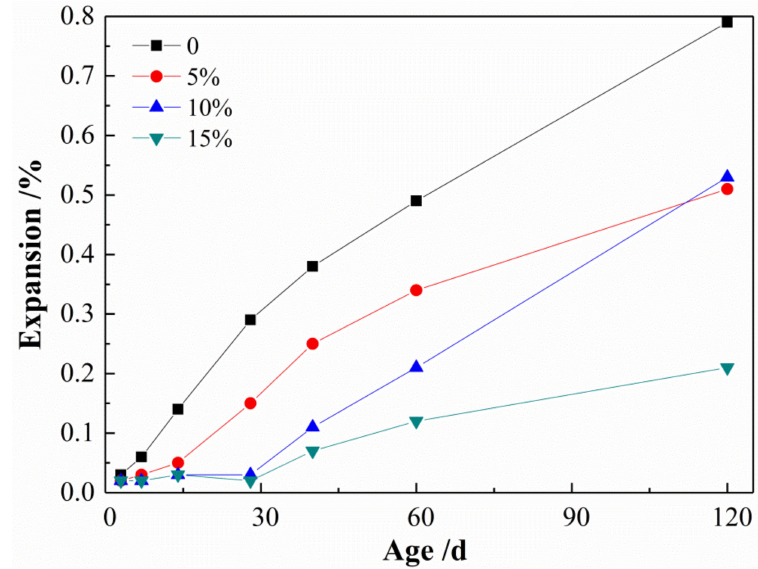
Figure 8. Effect of silica fume content on the mortar rod expansion